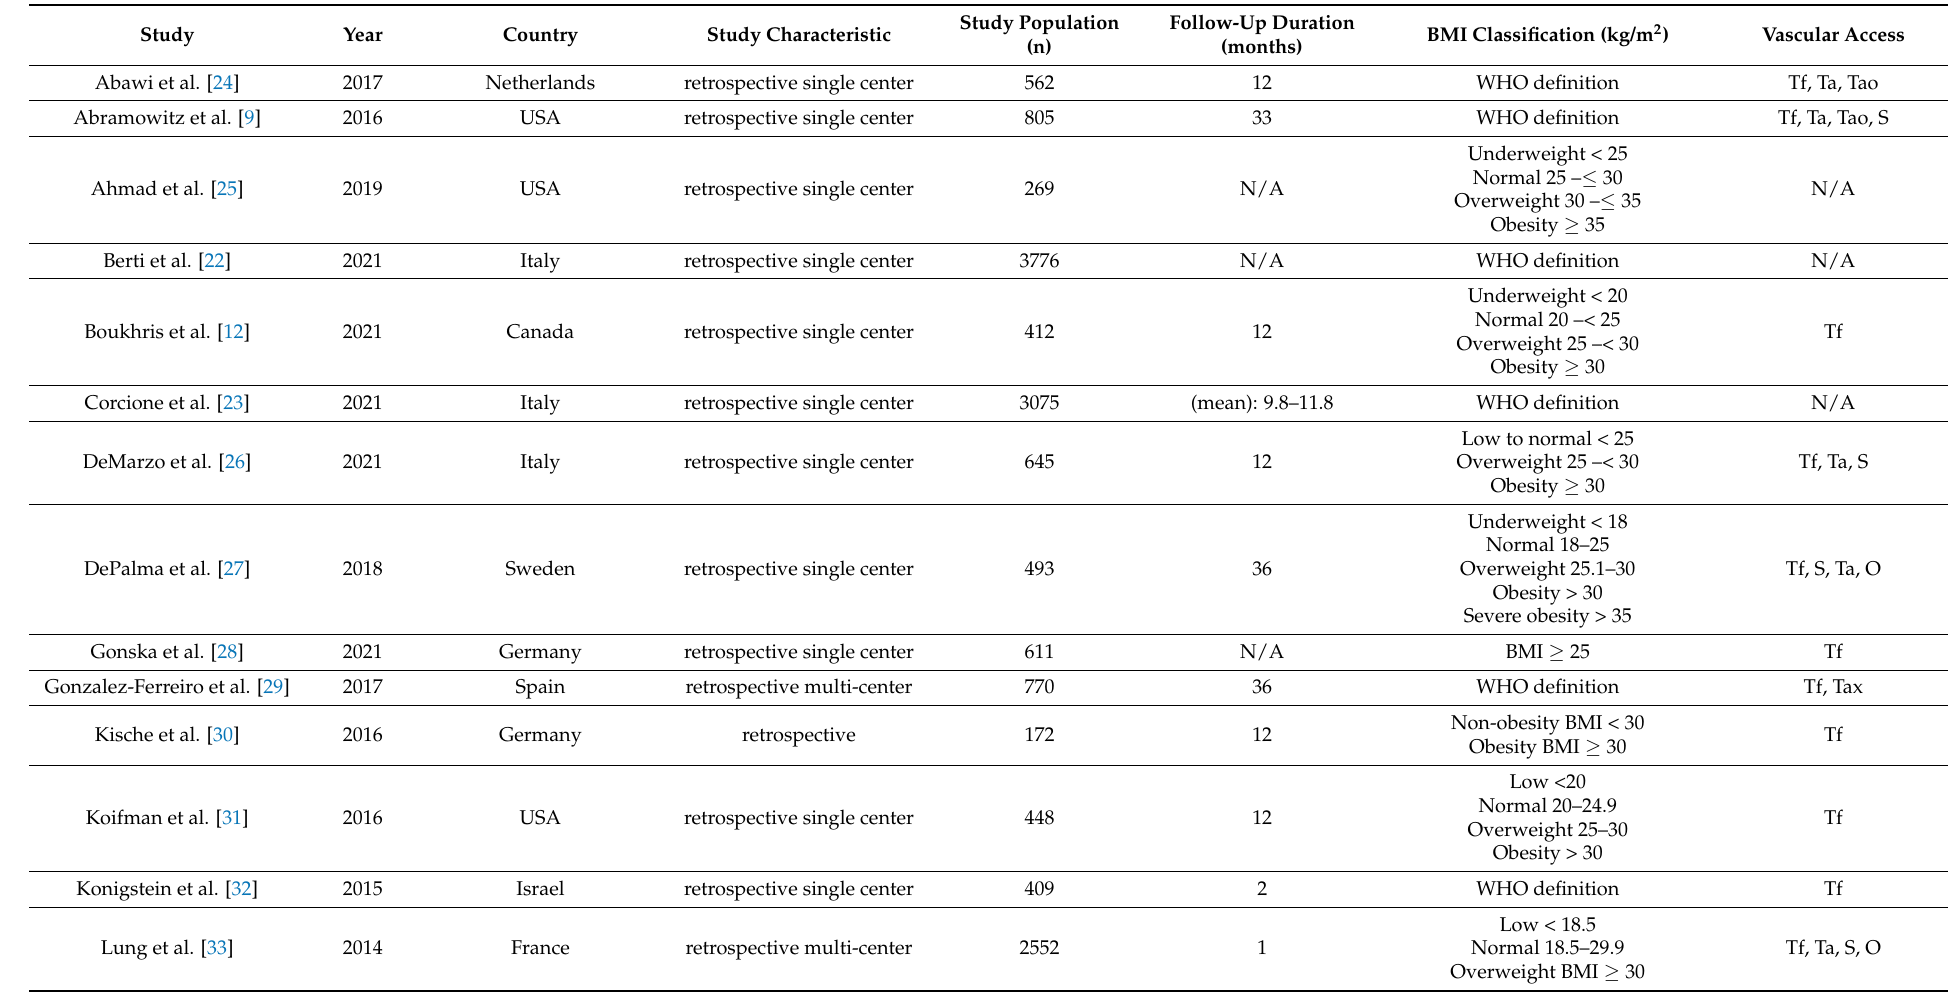
Table 1. Summary of the included